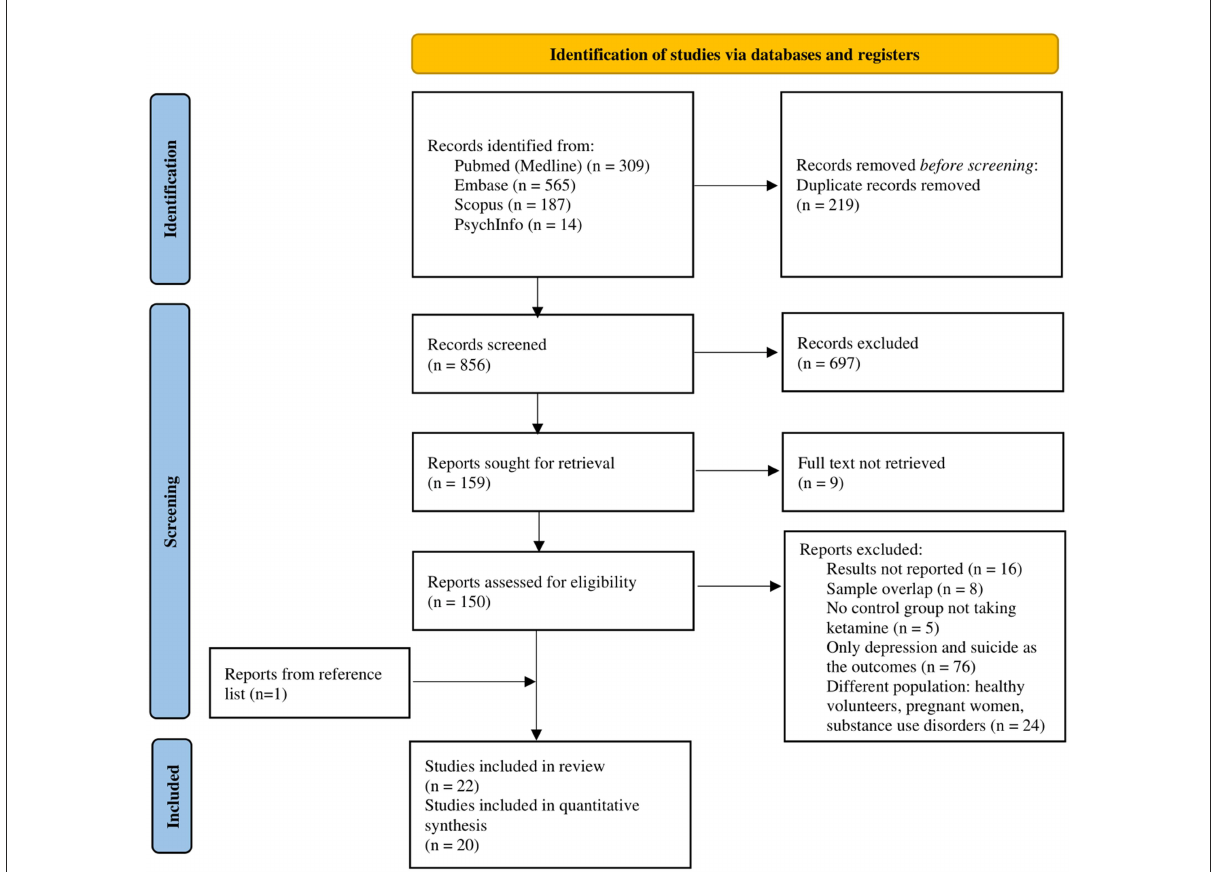
FIGURE1 Preferred Reporting Items for Systematic Reviews and Meta-analyses (PRISMA) flow